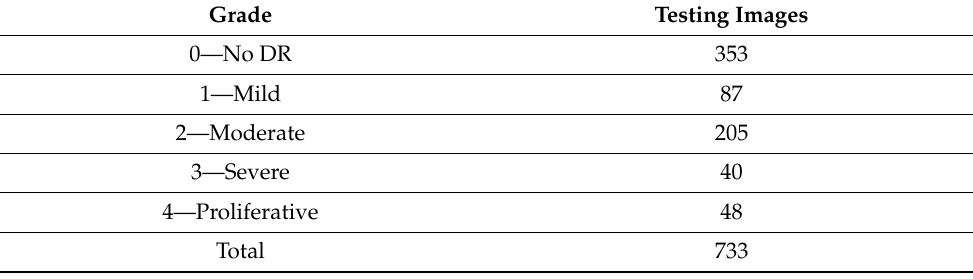
Table 4. Testing image distribution.